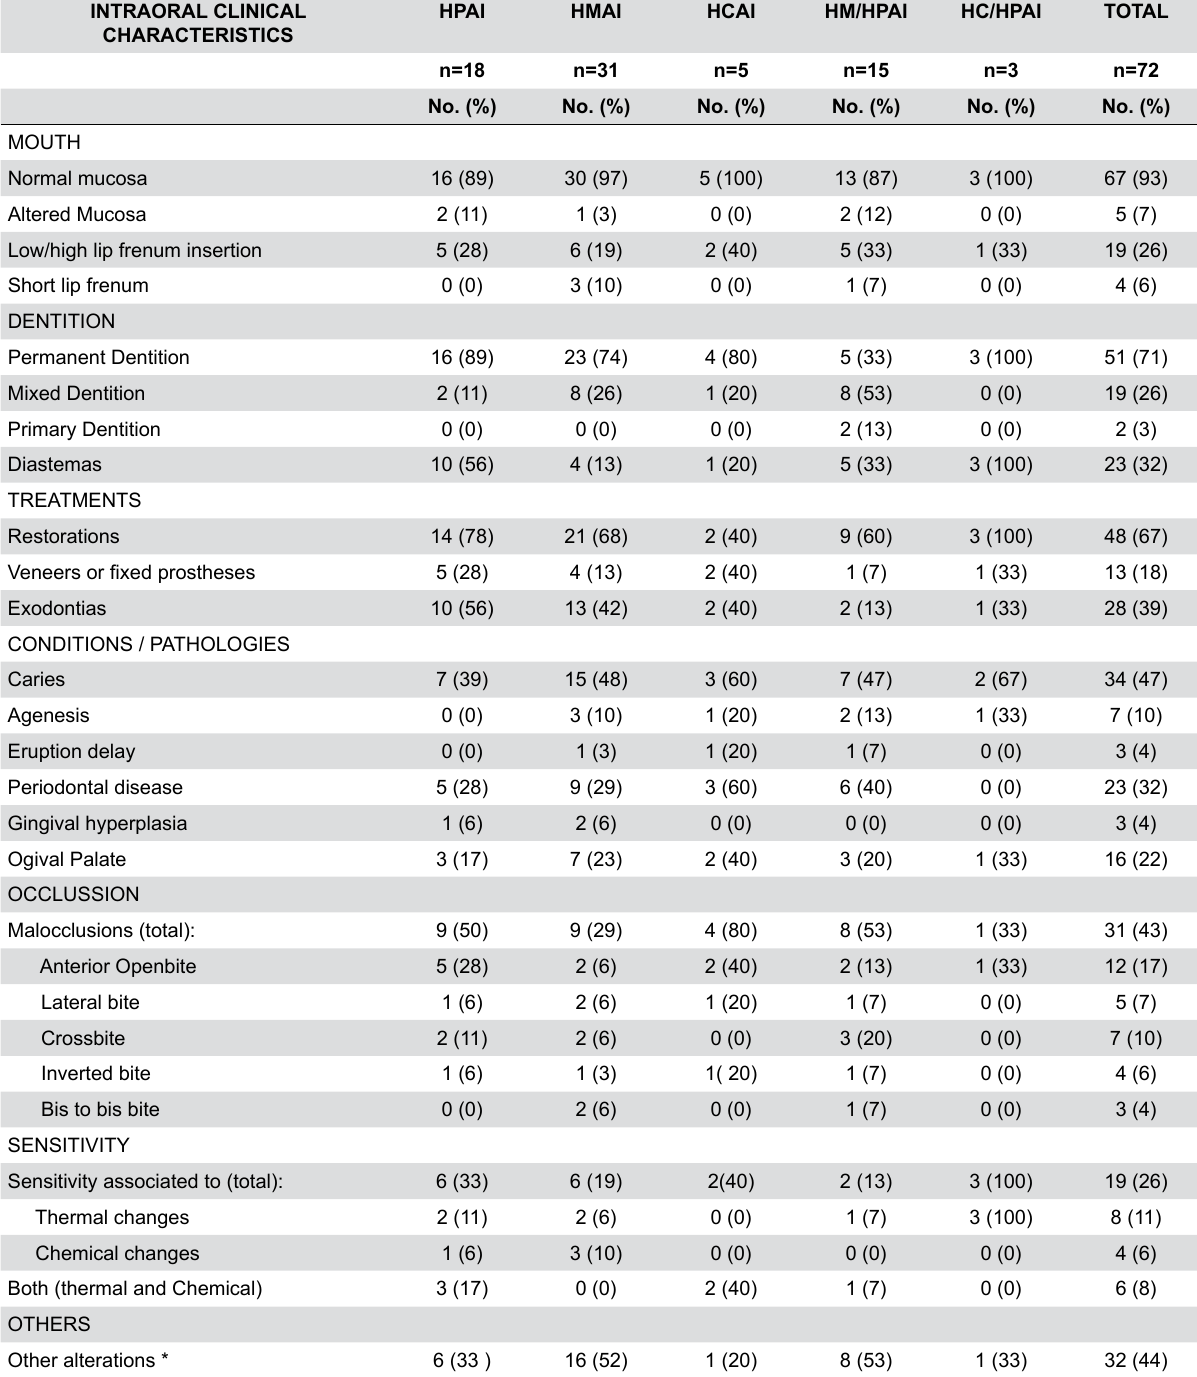
Table 3- Distribution of the intraoral clinical characteristics observed in the individuals affected with Amelogenesis Imperfecta according to clinical